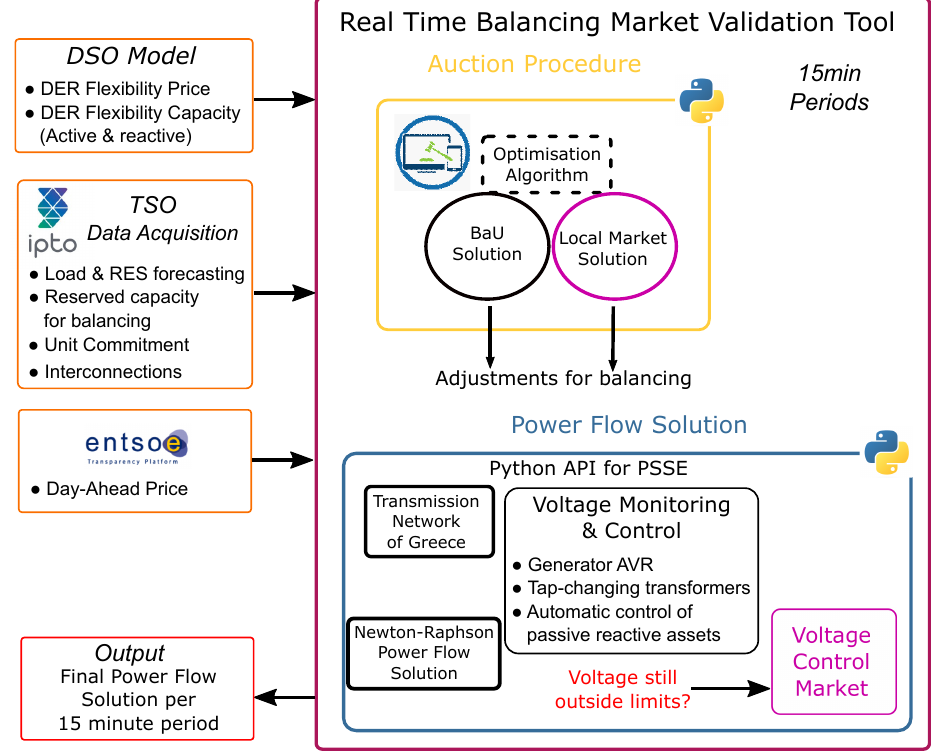
Figure 1. Architecture of the Real-Time Balancing Market Validation